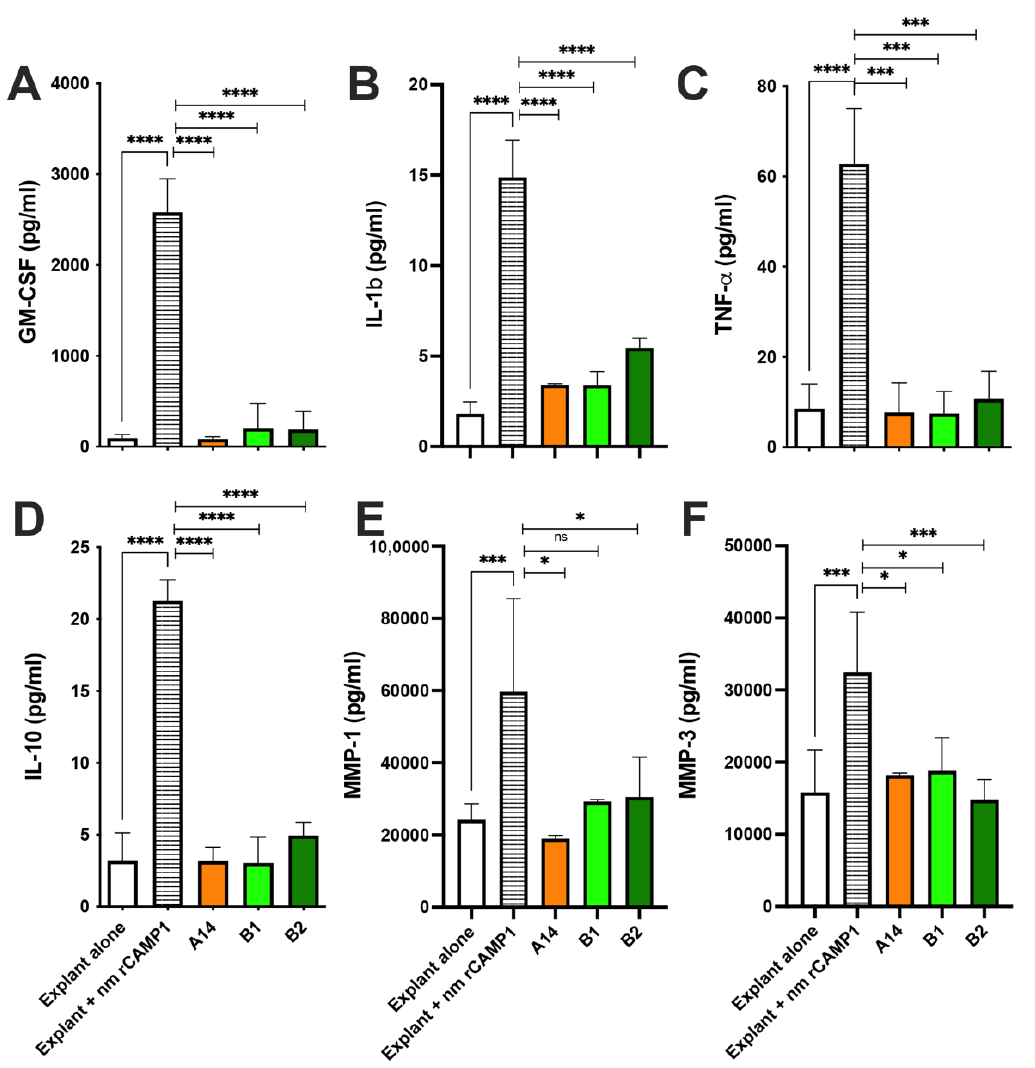
Figure 7. CAMP1-related peptides inhibit the production of nmrCAMP1-induced proinflammatory molecules ex vivo. Human skin explants were left untreated and unstimulated (Explant alone), were stimulated with nmrCAMP1 (10 µ g/mL) (Explant + nmrCAMP1), and treated with A14, B1 and B2 peptides (62.5 µ M) for 24 h and then stimulated with nmrCAMP1 for 18 h. ( A – F ) GM-CSF, IL-1 β , TNF- α , IL-10, MMP-1 and MMP-3 levels were measured by ELISA in the culture supernatant. The data shown are means ± SEM ( n = 6). Statistical significance is indicated by * ( p < 0.05), *** ( p < 0.001), and **** ( p < 0.0001).